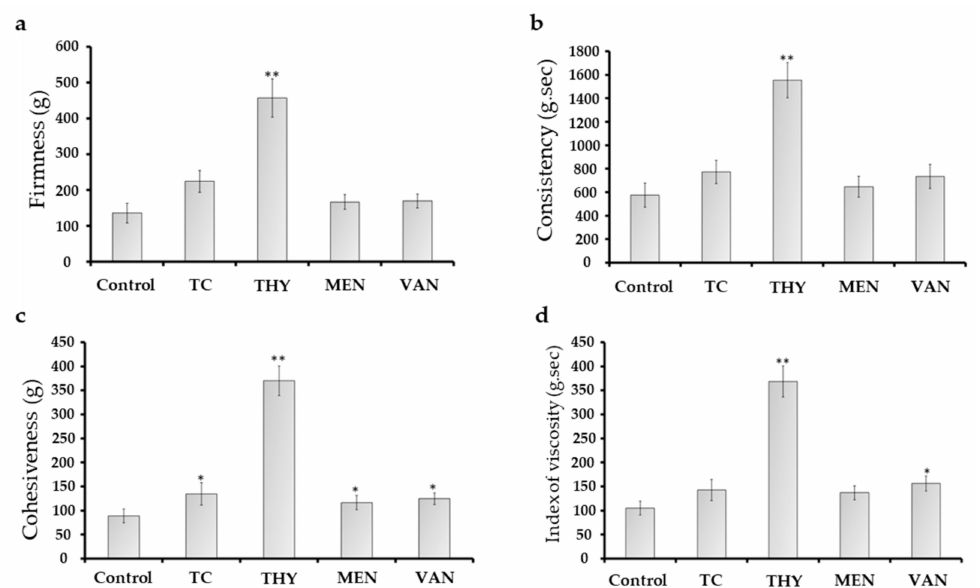
Figure 1. Texture properties of the different mixtures of TC, THY, MEN, or VAN egg yolk ice creams. ( a ) Firmness, ( b ) Consistency, ( c ) Cohesiveness, ( d ) Index of viscosity. *, **: The column differs significantly (( p ≤ 0.05) and ( p ≤ 0.01),